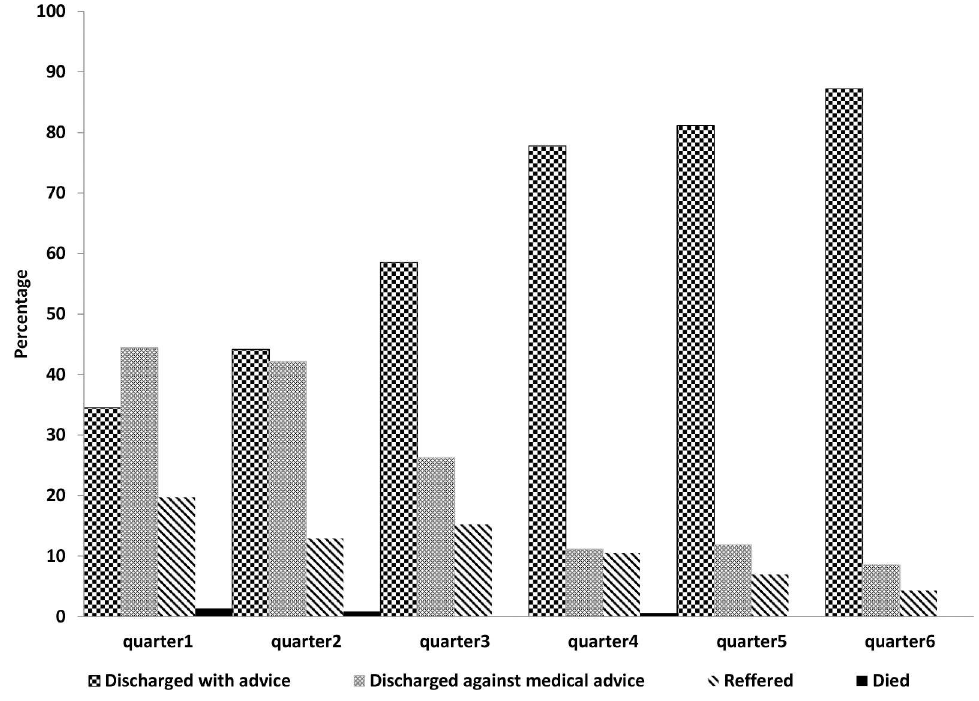
Fig 3. Quarter wise trend in hospital outcome of syndromic sepsis patients (August 2013-March